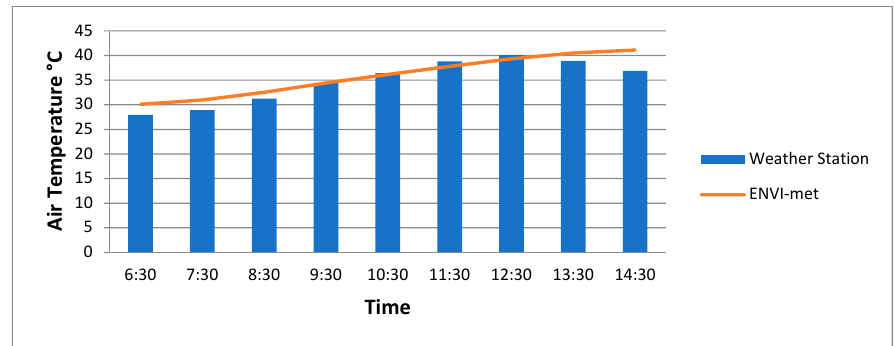
Figure 3. Relationship between predicted and measured Ta for Receptor 1: 9:30 a.m. to 12:30 p.m. Weather station data and simulated (ENVI-met) air values are close, with a relatively short time interval. There is a difference between the measured and simulated values for the time at which the air temperature values begin to fall. For the measured data, this moment occurs at 12:00 p.m., whereas for the simulated values, this point occurs at 2:30 p.m.; also, the temperature decreases at a much slower rate than that observed in the measured values. In this work, the simulation results are presented for two specific hours that are representative of the region: 10 a.m. and 8 p.m. The former is a time of intense solar radiation in Rio de Janeiro city, and the latter is two hours after sunset. It is interesting to observe the effects on the environment of exposure to intense heat during the day. Figure 4 shows the temperature results for 10 a.m. From this figure, it is notable that in the configuration for1930, much of the region does not reach 35°C. From the density and changing urban morphology, the observed temperature on the block experienced an